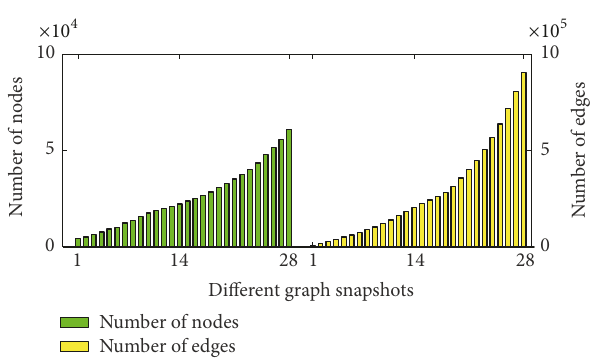
Figure 1: Number of nodes and edges per month of the Facebook